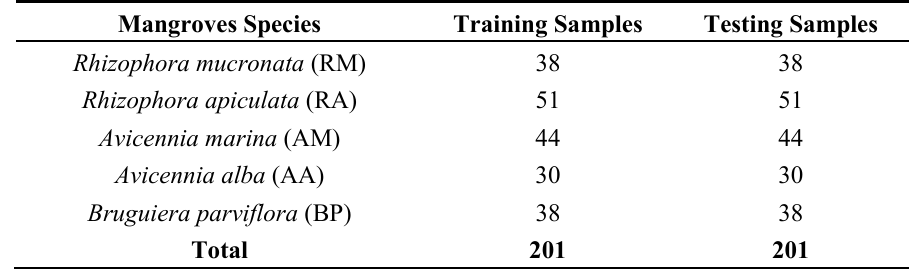
Table 1. The number of training and testing samples per species and their